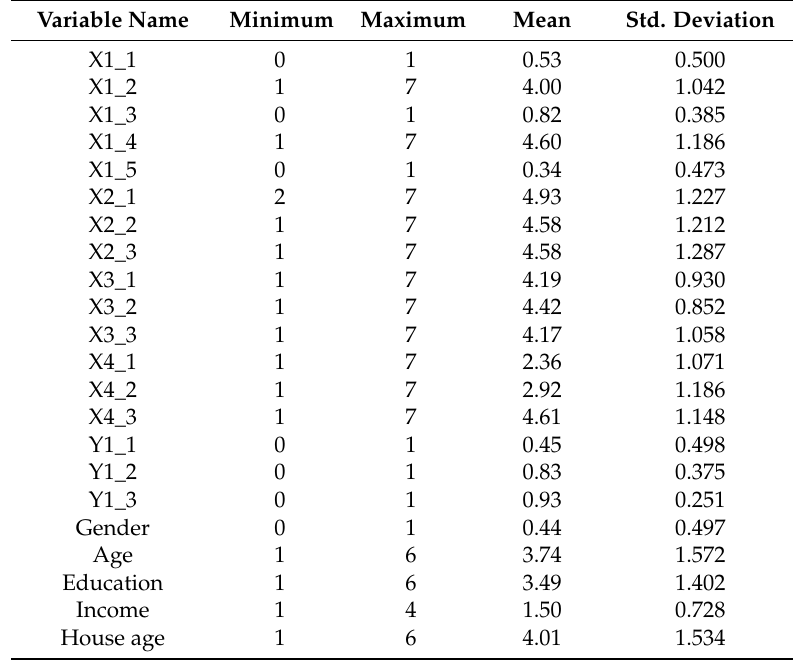
Table 3. The descriptive statistics for each